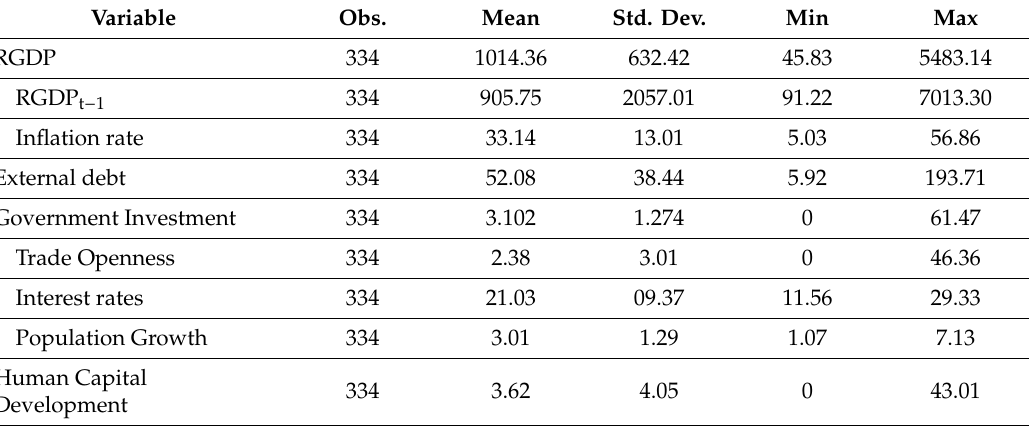
Table 1. Descriptive statistics of the